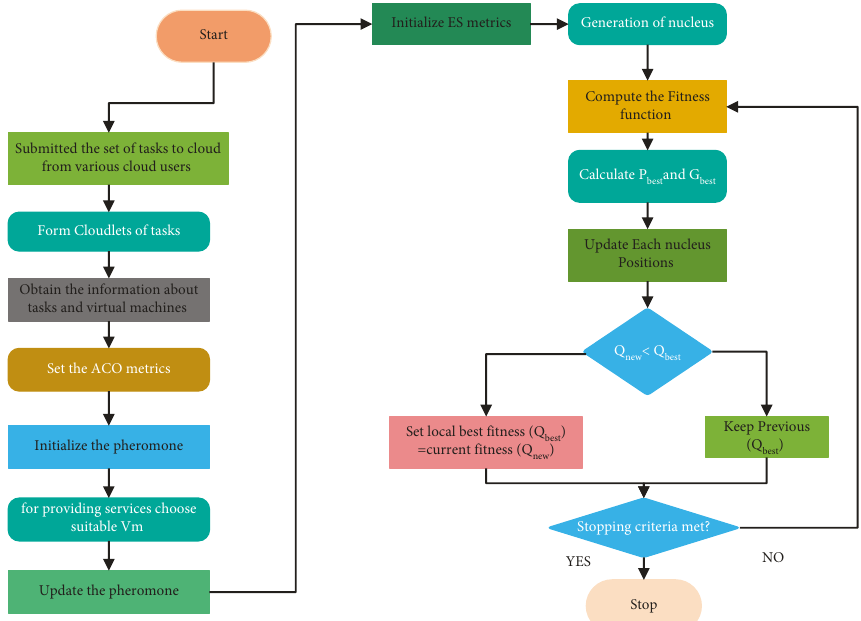
Figure 6: The flow chart of the proposed hybrid ES-ACO.